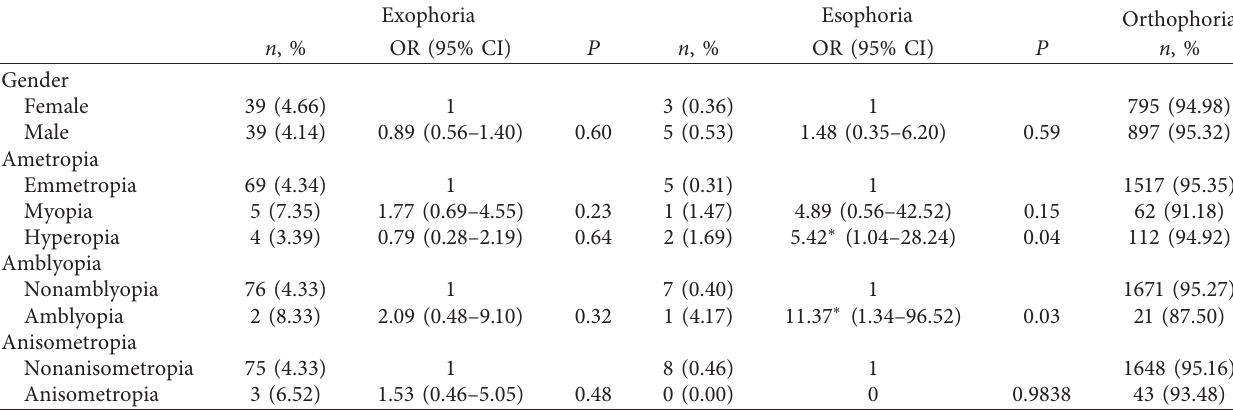
∗ The prevalence of heterophoria was associative with corresponding factors. Table 5: Association of heterophoria with gender, amblyopia, ametropia, and anisometropia for grade-one students at distance fixation in Lhasa, Tibet Autonomous Region,